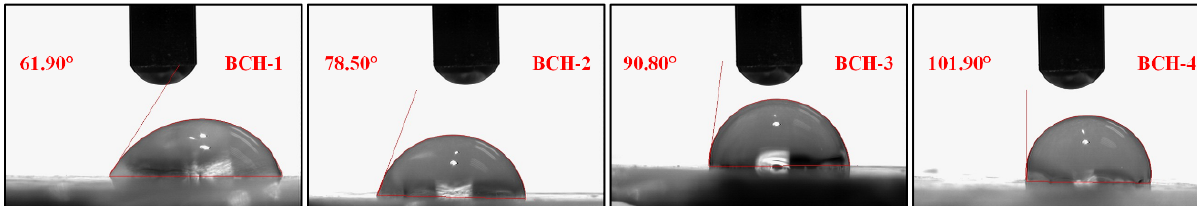
Figure 4. The measurement of water contact angles at different time intervals to determine the hydrophilicity of hydrophobicity of hydrogels with an increasing amount of rGO and time (t = 5 s).